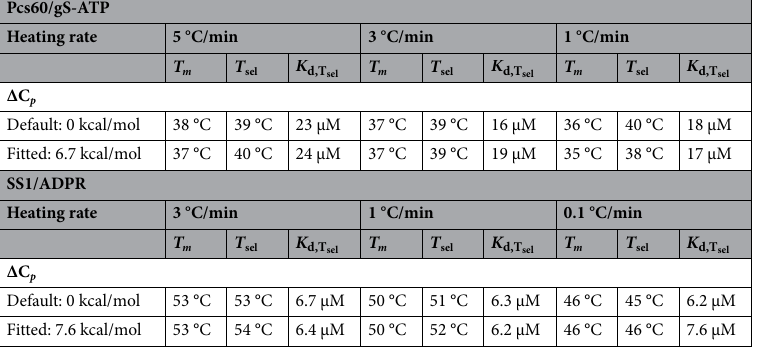
Table 3. Summary of isothermal analysis for different heating rates for Pcs60/gS-ATP and SS1/ADPR for different heating rates shown in Fig. 8. The analyse were done for two different ∆C p values: a default value of 0 and the fitted value for the 1 °C/min measurement (cf. Table 1). T sel is the temperature with the lowest fitting error for K d . For Pcs60 we have used the heating rates 7, 5, 3 and 1 °C/min. For SS1 heating rates of 3, 1 and 0.1 °C/min are